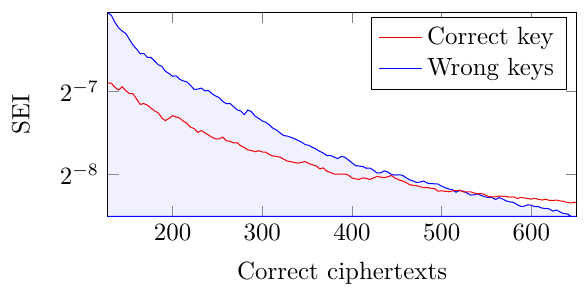
Figure 6: Attacks on HW AES co-processor, ATXmega 256A3, detection countermeasure. SEI of the correct key (SEI R ) vs. best SEI of a wrong key (SEI ∗ 550 correct ciphertexts were required, stemming from about 800 faulted